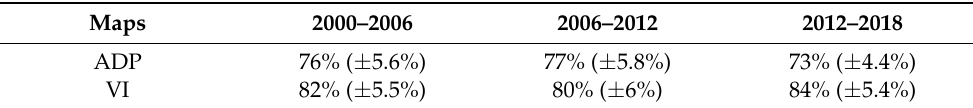
Table 3. Overall map accuracy of the ADP and VI maps for 2000–2018, standard error (SE) is given in parentheses.